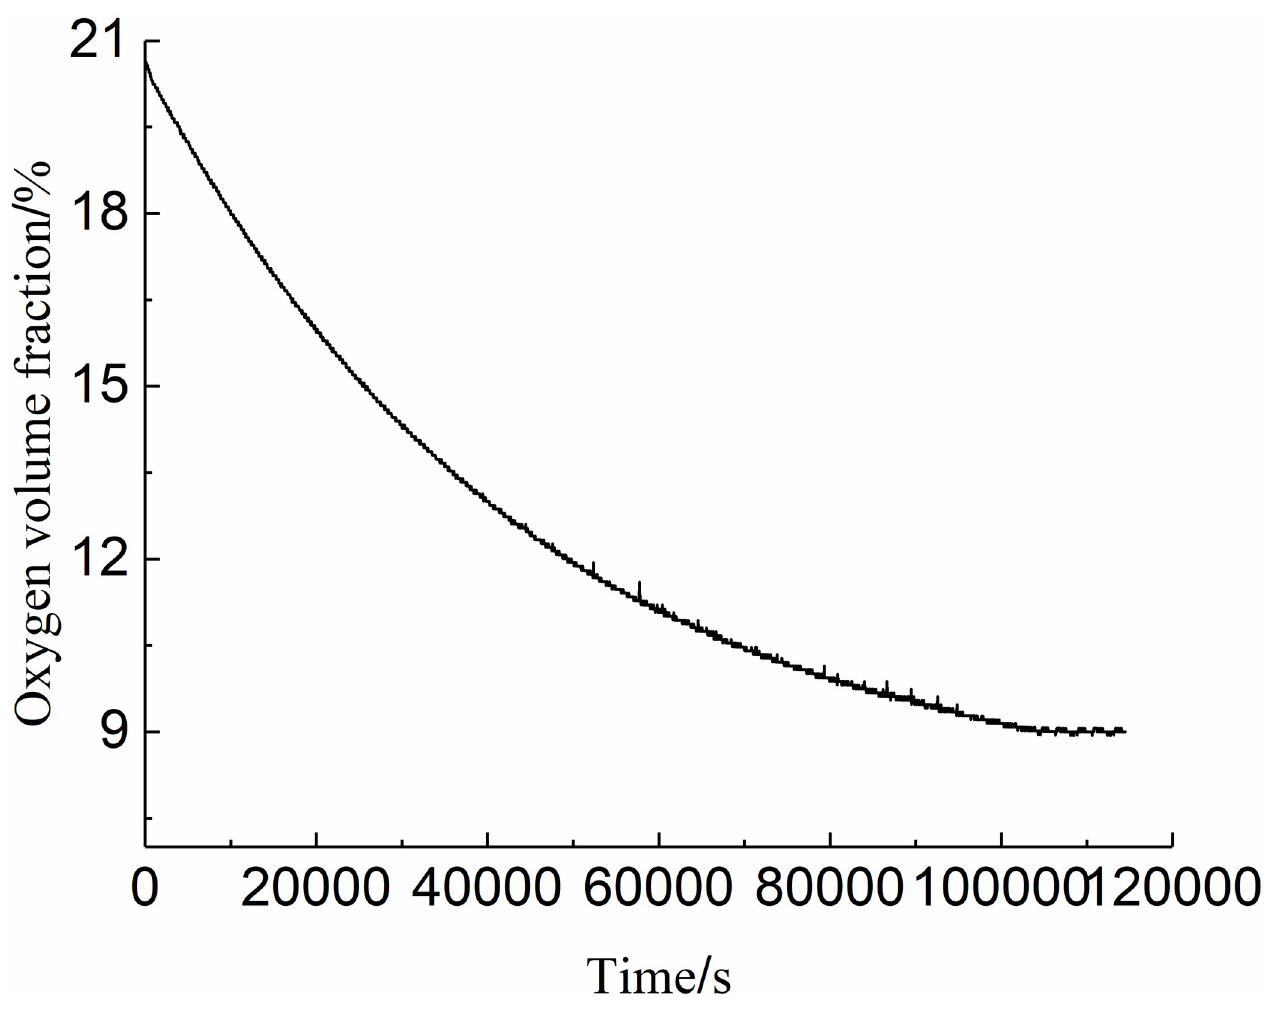
Fig 2. Experimental curve of closed oxygen consumption of Qipanjing coal sample.